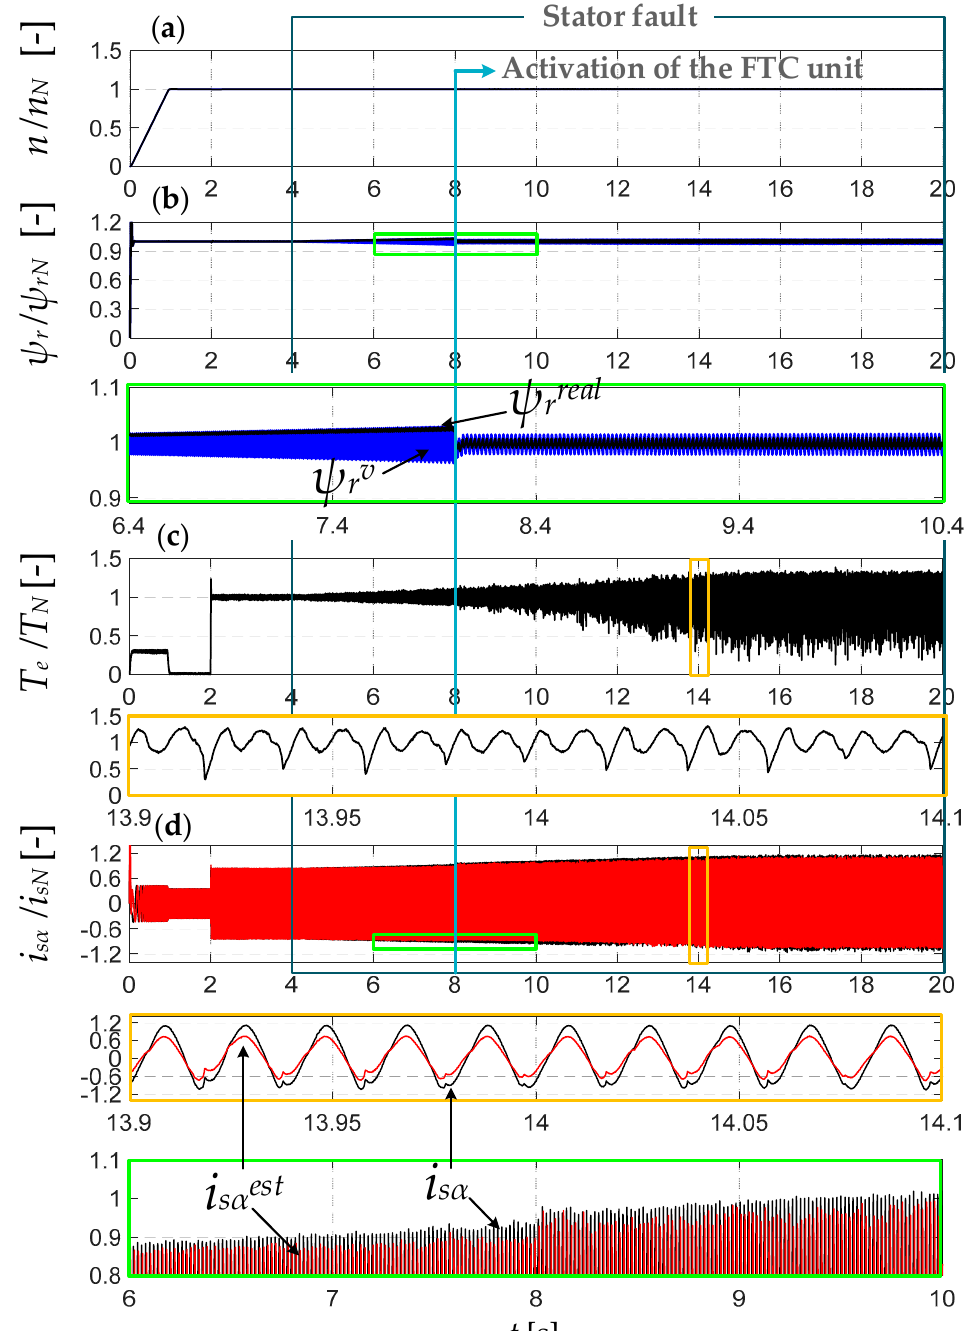
Figure 10. Operation of closed-loop control scheme (DFOC) during ITSC with the modified voltage model (MVM) in the control structure: ( a ) reference and real rotor speed, ( b ) estimated and real rotor flux, ( c ) electromagnetic torque, ( d ) estimated and real stator current in phase A; (simulation results), ( n ref = n N , T l = T N ).